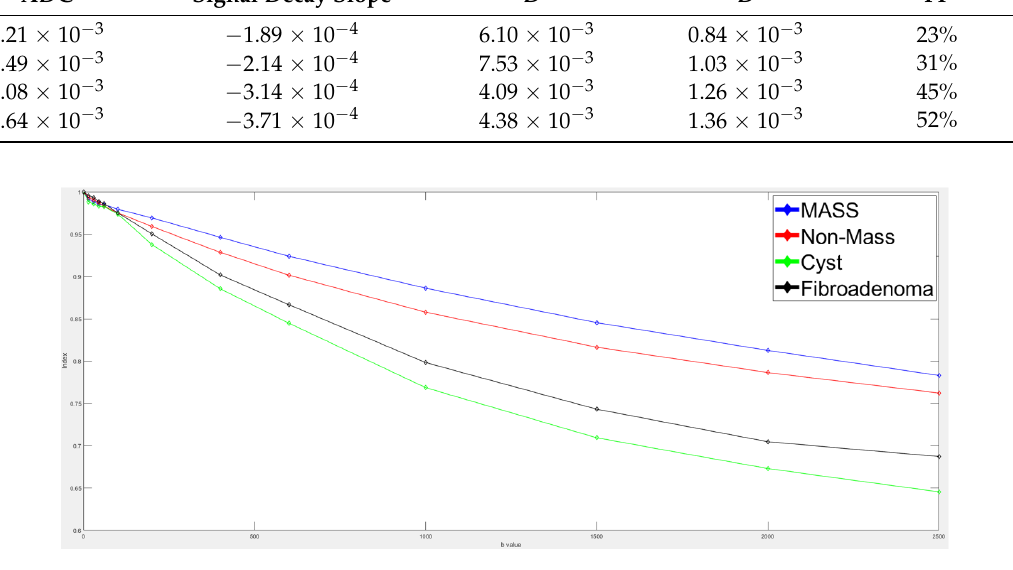
Figure 17. Signal intensity decays using K-CEM.